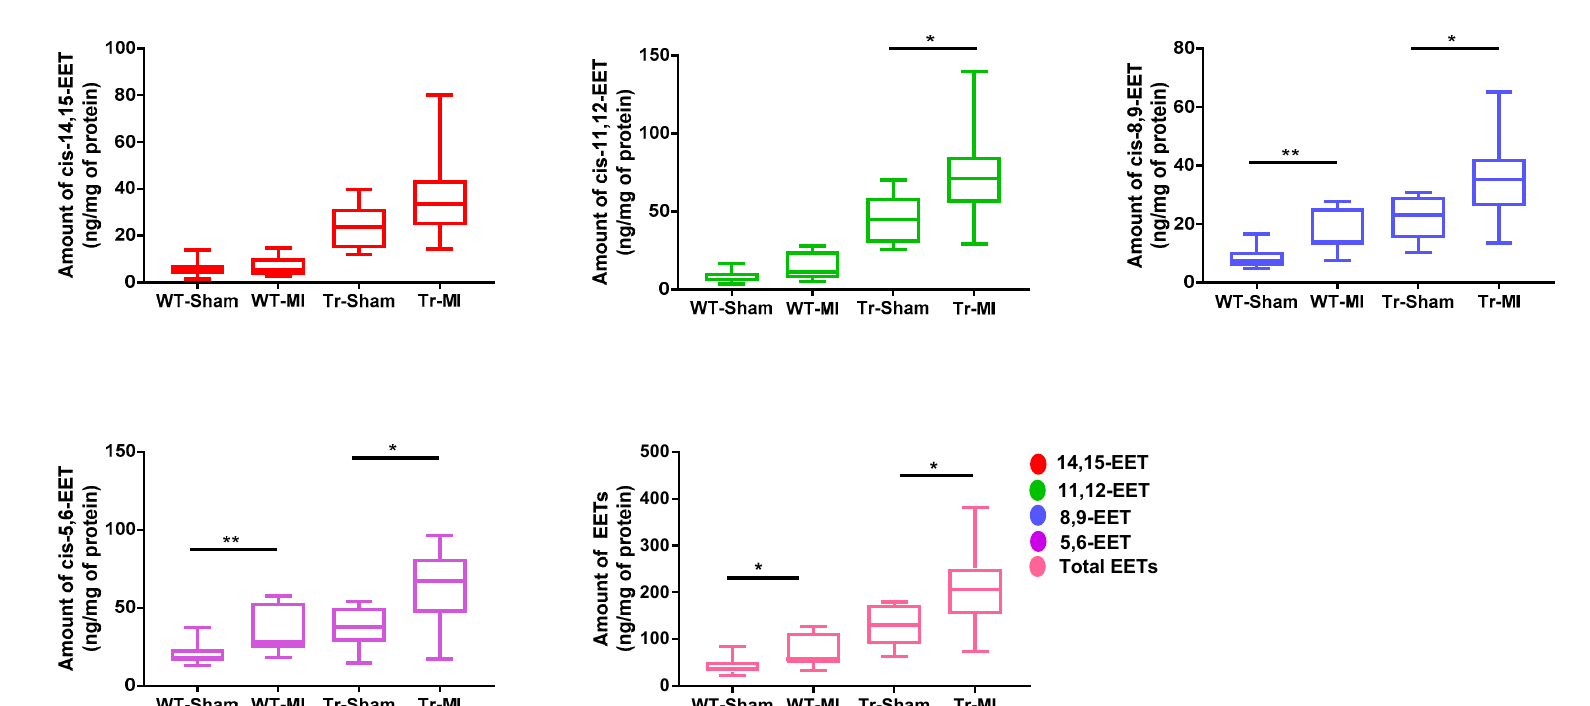
Figure 5. Cis- epoxyeicosatrienoic acid (EET) regioisomers and total cis- EET levels extracted from cardiac tissue of wild-type (WT) and transgenic (Tr) mice subjected to sham or myocardial infarction (MI) surgery. Eight WT mice (four female (F) and four male (M)) and nine Tr mice (five F and four M) were subjected to sham surgery and nine WT mice (four F and five M) and nine Tr mice (four F and five M) were subjected to MI surgery. * indicates p ≤ 0.05 and ** indicates p ≤ 0.01.